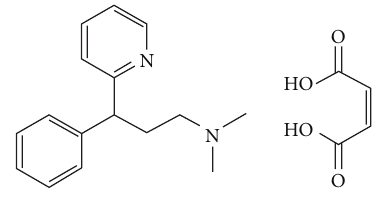
Figure 1: Structure of pheniramine